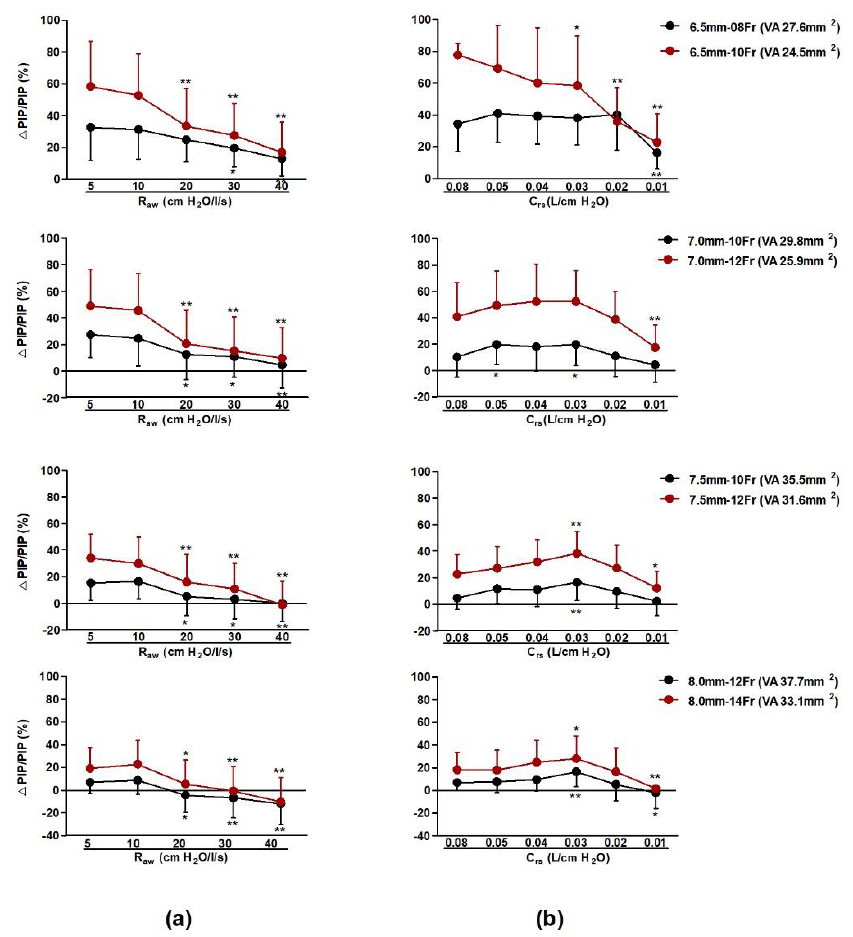
Figure 3. The effect of the ventilation area on △ PIP/PIP% during VC-CMV: ( a ) Airway resistance of pulmonary mechanics for the obstructive system; ( b ) Lung compliance of pulmonary mechanics for the restrictive system. △ PIP/PIP% decreased for the larger ventilation area and significantly reduced for severe respiratory systems. △ PIP: (delta) suctioning peak inspiratory pressure level substrates a baseline peak inspiratory pressure level; △ PIP/PIP%: percentage of PIP (baseline PIP level) divided by △ PIP; VC-CMV: volume control continuous mandatory ventilation, this mode is set to VT 0.6 L with peak flow 60 Lpm; R aw: airway resistance; C rs : lung compliance; ETT: endotracheal tube; SC: suction catheter; VA: ventilation area (ETT cross-section area minus SC cross-section area); 6.5 − 08: 6.5 mm ETT paired with 08 Fr SC, and so on. The independent samples t -test was used to compare with 0.08 L ･ cm H 2 O −1 of C rs and 5 cm H 2 O ･ L −1 ･ s of R aw group. * p < 0.05, ** p < 0.01.